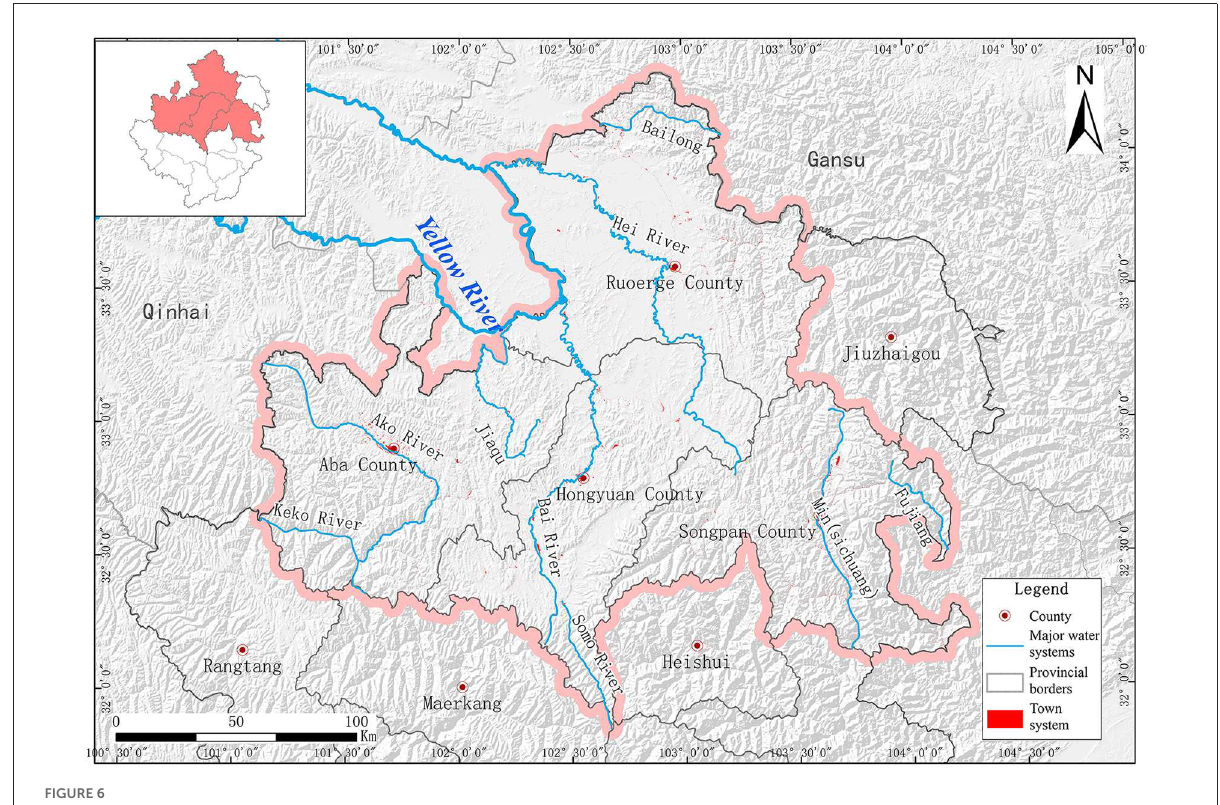
FIGURE6 Urban ecosystem distribution in the study